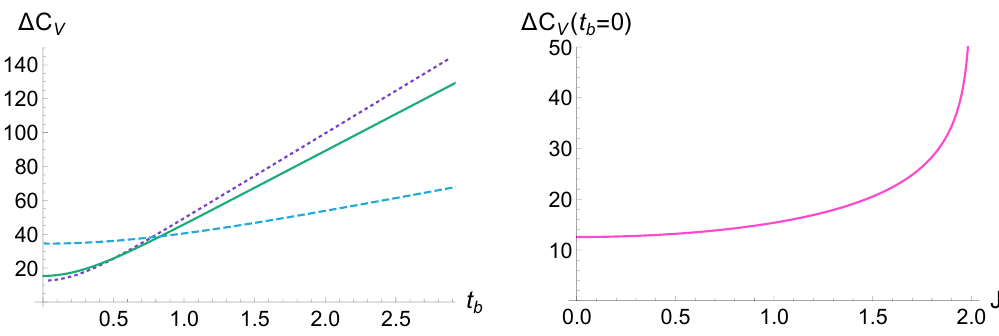
Figure 9 . (Left) ∆ C V ( t b ) for J = 0 . 1 (purple dotted), J = 1 (green solid) and J = 1 . 9 (blue dashed). (Right) ∆ C V ( t b = 0) as a function of J . In both plots M = 2 , ‘ = G N = 1